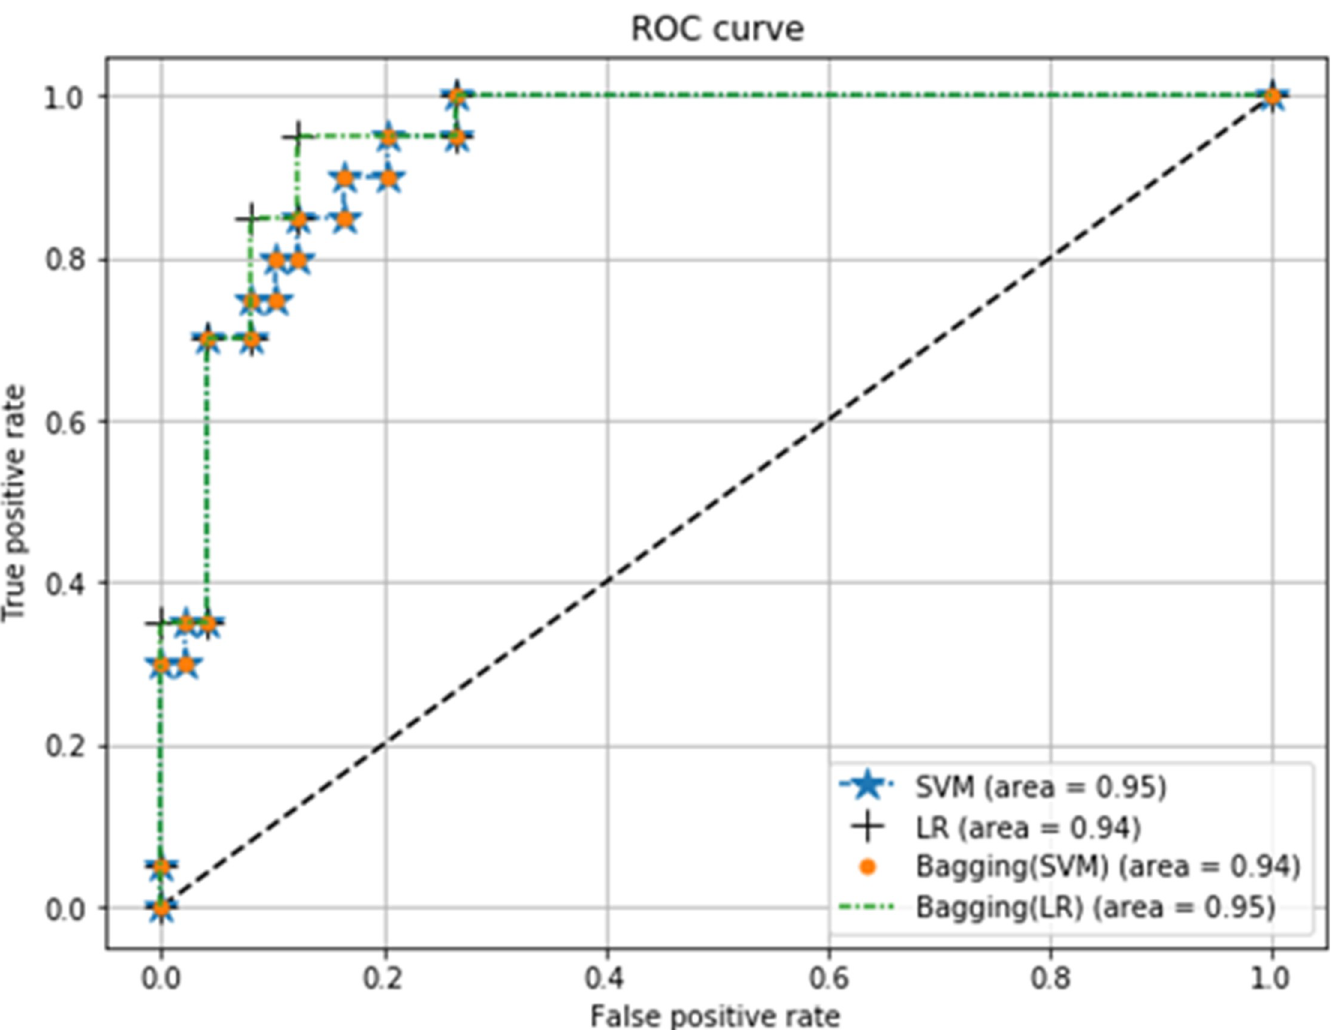
Fig 5. ROC curves with 5 features for SVM, LR, bagging SVM and bagging LR.